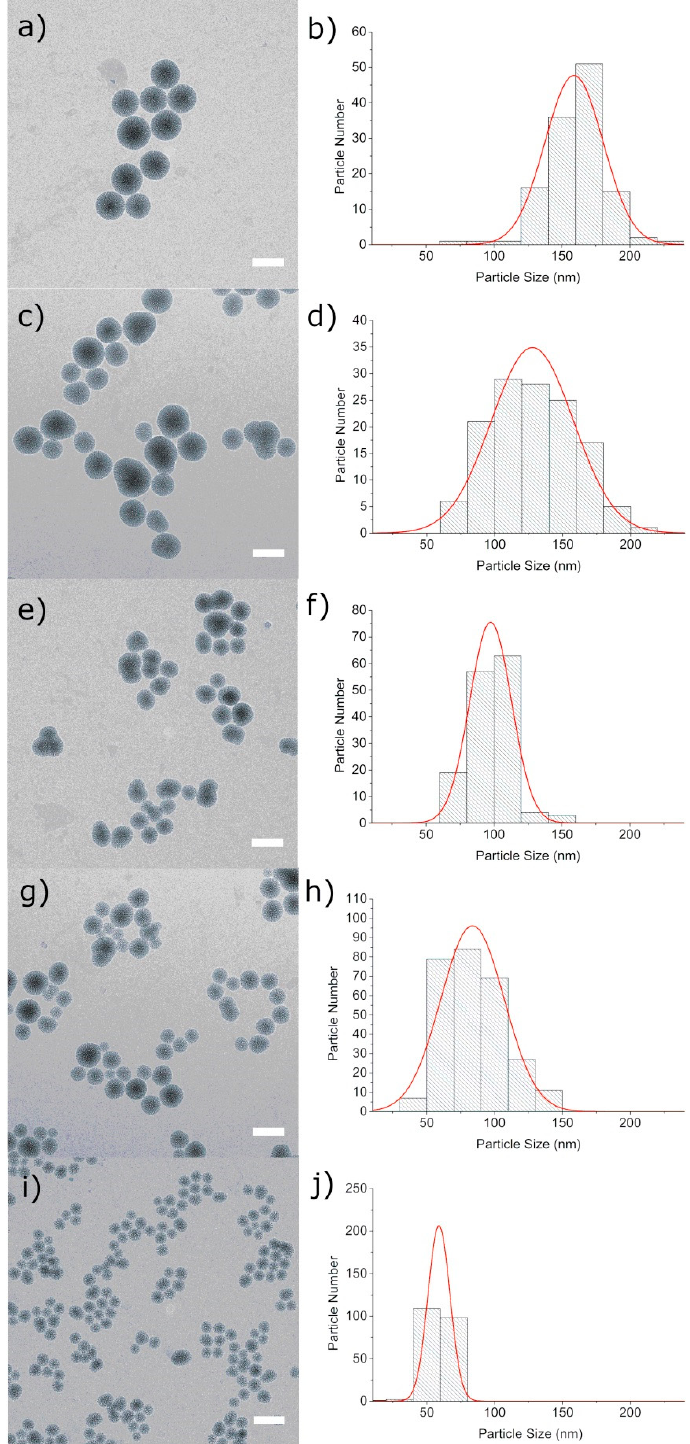
Figure 2. TEM micrographs of ( a ) MSN160 nm, ( c ) MSN130 nm, ( e ) MSN100 nm, ( g ) MSN80 nm, ( i ) MSN60 nm and corresponding particle size distribution histograms obtained from TEM images ( b , d , f , h , j ). Scale bar represents 150 nm.